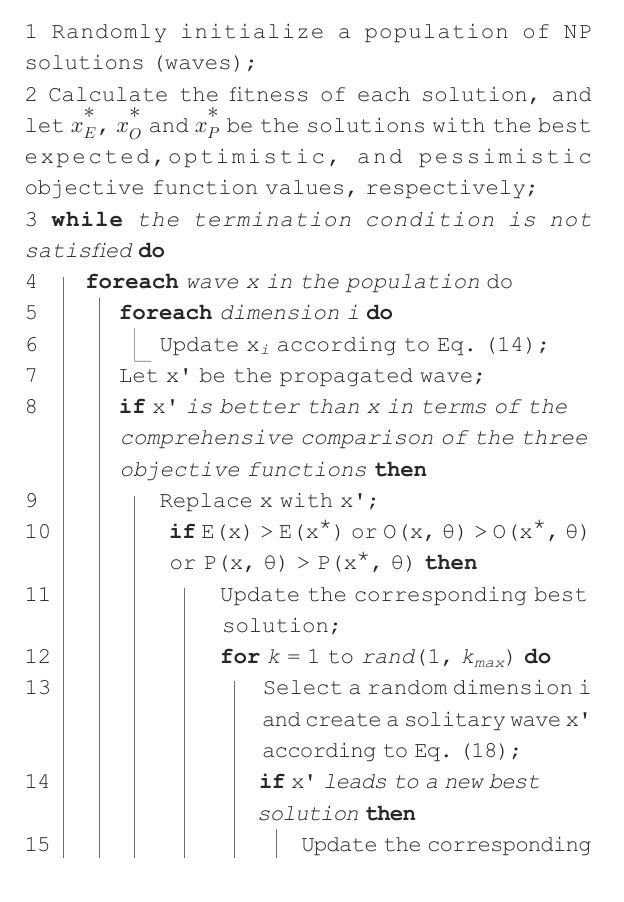
TABLE 1 Basic information of the six agricultural regions for the applications of the proposed algorithm.